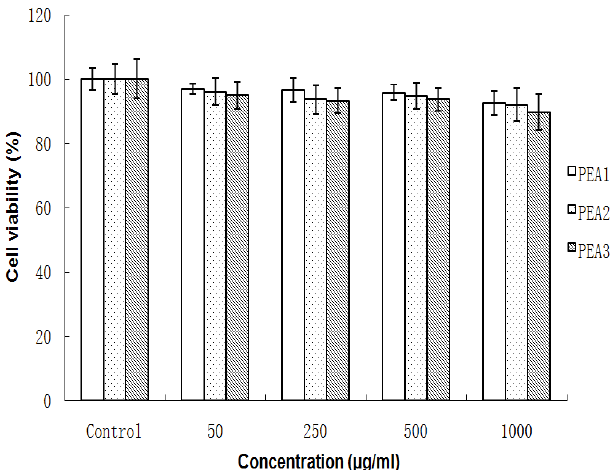
Figure 2. Viability of Caco-2 cells treated with the PEA1, PEA2, PEA3 nanoparticles at various concentrations for 48 h. Data are expressed as mean values (with standard deviation) of six experiments.